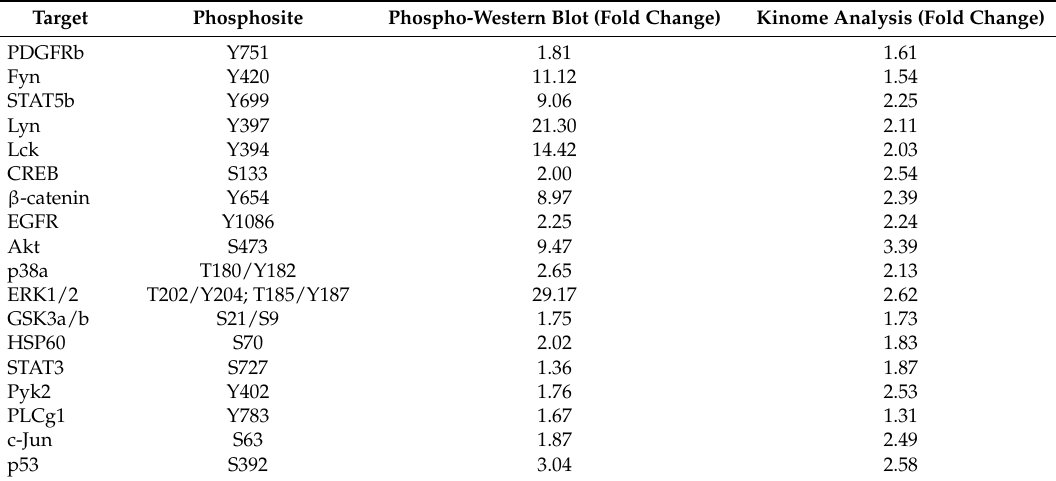
Table 1. Conservation of phosphorylation status between kinome analysis and phospho-Western blots. blot and by peptide kinome